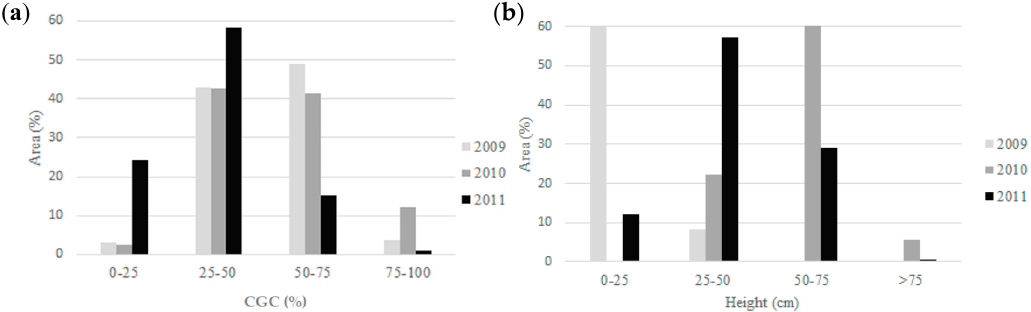
Figure 7. Area in percentages occupied by the ranges of ( a ) Coverage of Grass Canopy (CGC) and ( b ) grass height in the region Cuchillas de la Zarca.